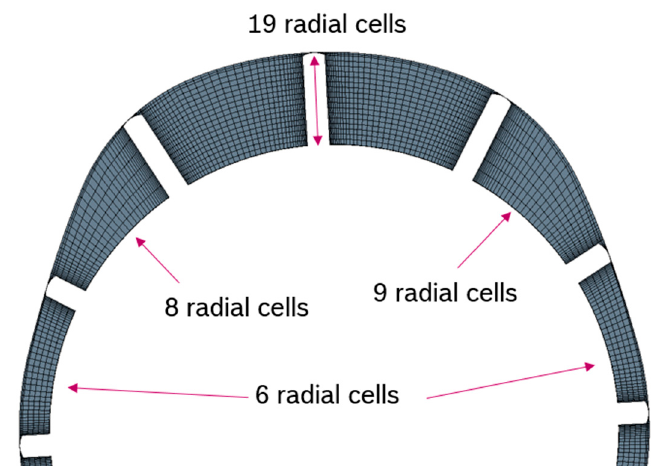
Figure 8. Computational cell distribution in radial direction in the rotor mesh.